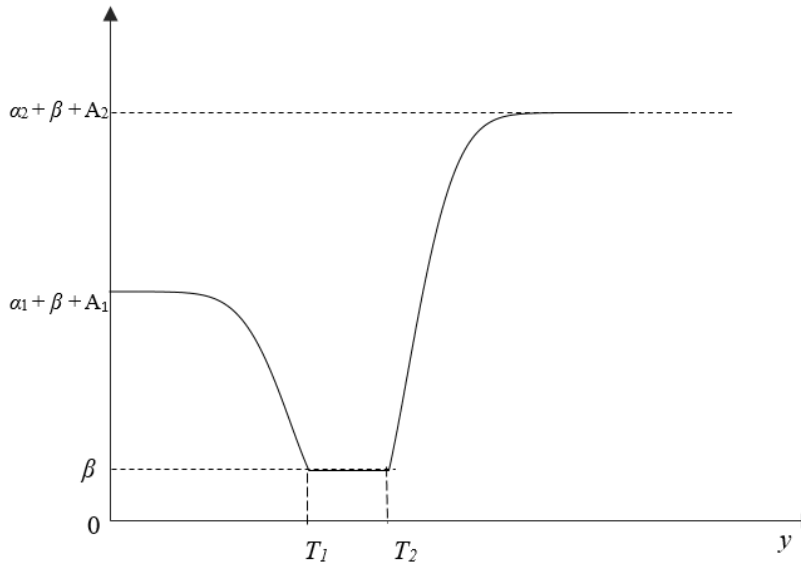
Figure 3. Grey quality gain–loss function curve of asymmetric-hyperbolic tangent compensation ( β > 0).